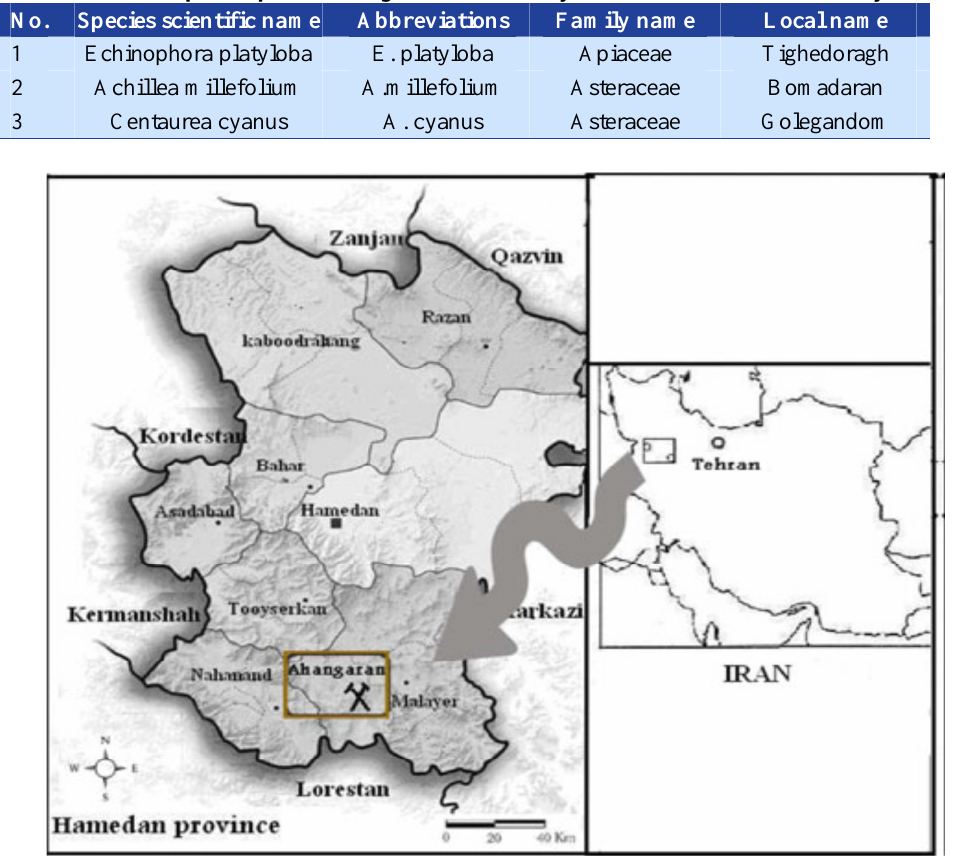
Figure 1. Location of the study